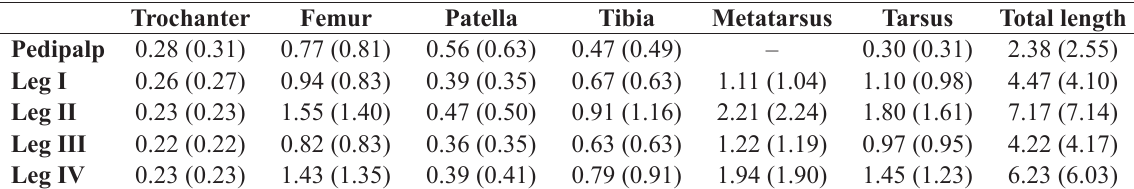
Table 8. Length of appendage-segments in millimeters in N. bidentatum gruberi Novak, Slana Novak, Kozel & Raspotnig ssp. nov. from Dolenje Laknice, Slovenia: ♂ holotype